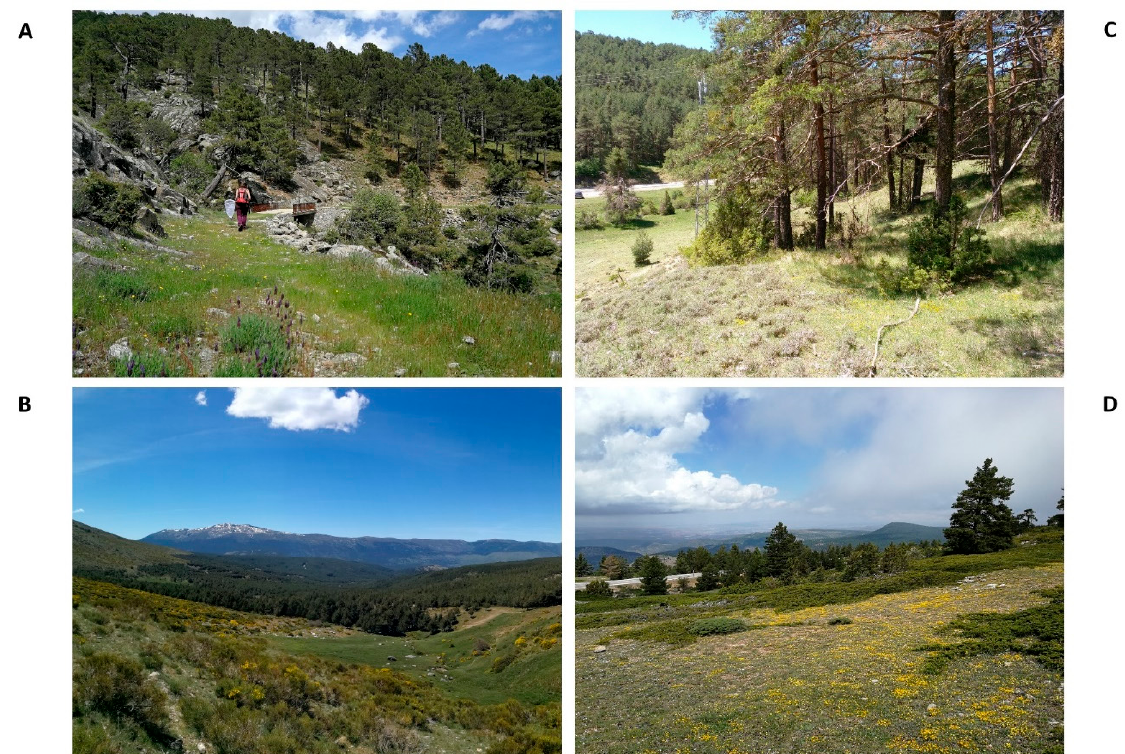
Figure 2. Photographs of habitats in the four mountain study regions. ( A ) Sierra de Gredos, ( B ) Sierra de Guadarrama, ( C ) Sierra de Albarrac í n, ( D ) Sierra de Javalambre. The main habitat types are: H1—pine forest; H7—open scrubland; H10—short